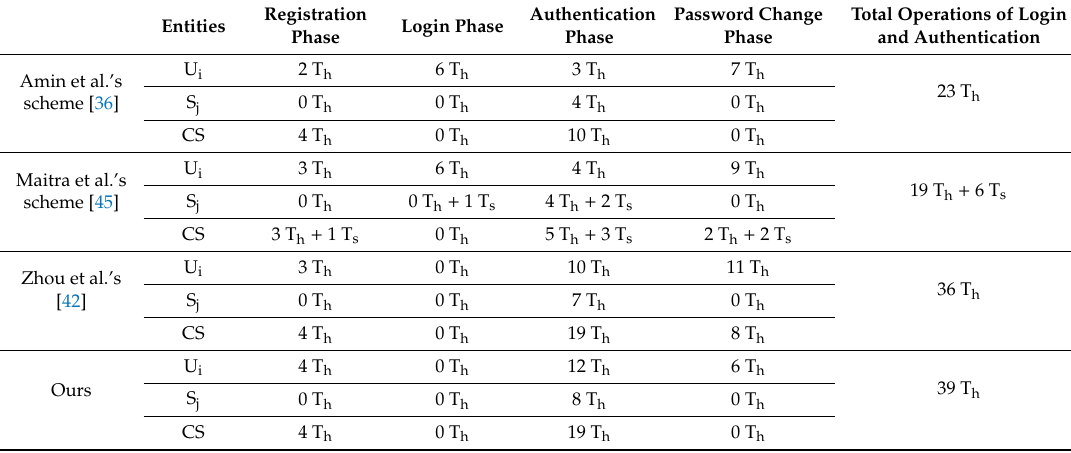
Table 2. Calculation cost comparison of four certification schemes.